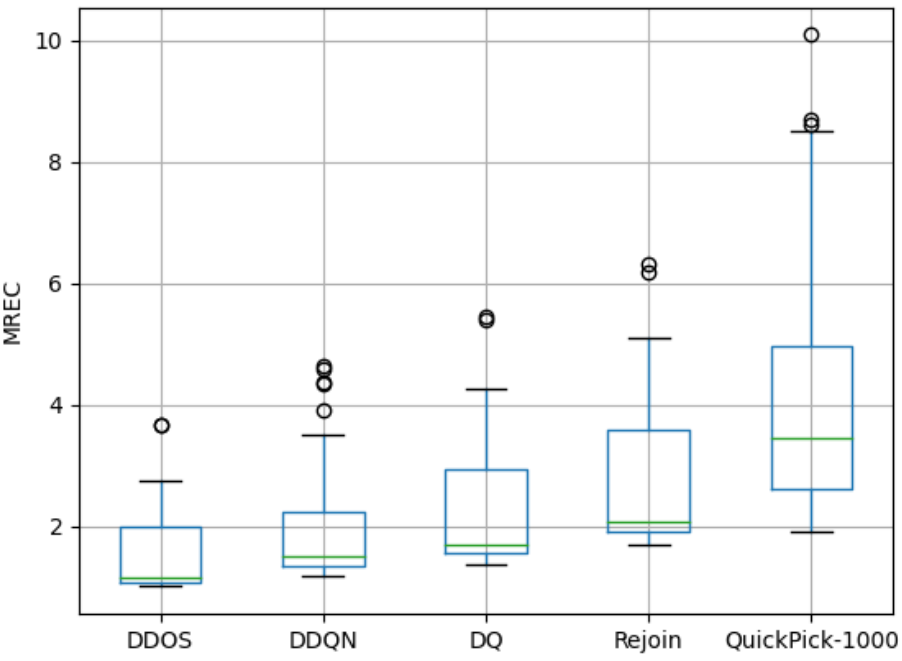
Figure 8. Relative execution cost of the DDOS, DDQN, DQ, Rejoin, and QuickPick-1000